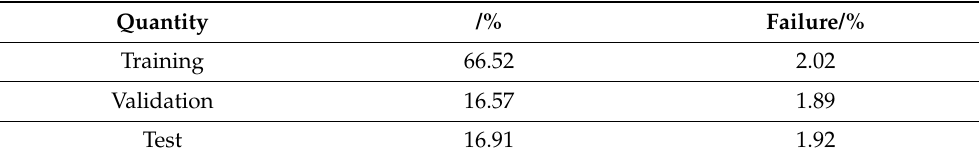
Table 12. Amount of data attributed to each of the sets and the percentage corresponding to failures.